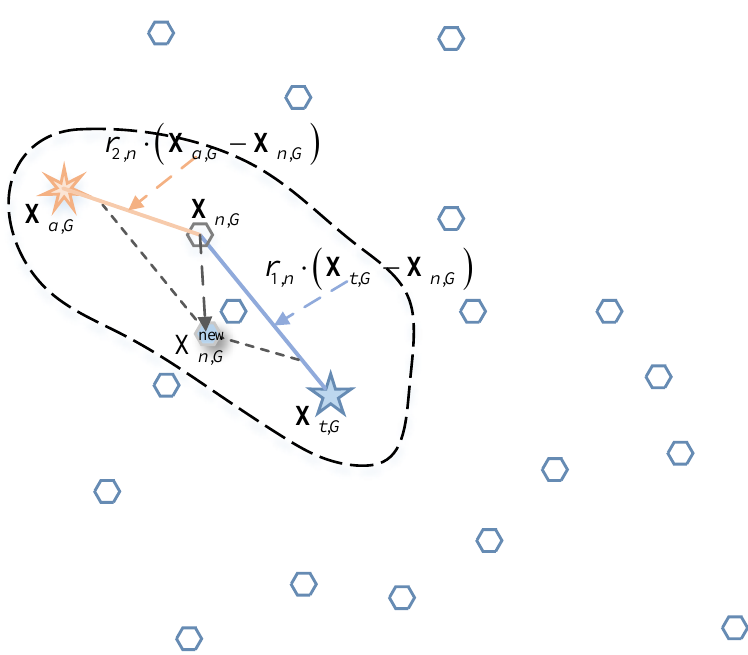
Figure 8. Schematic diagram of the two-dimensional new individual generation.